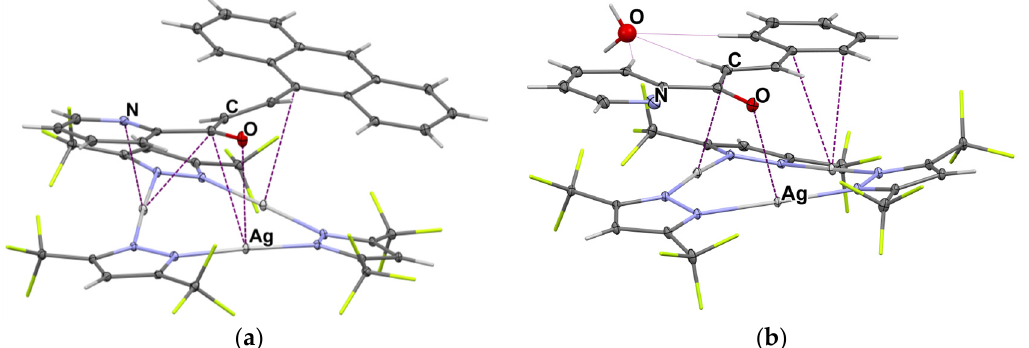
Figure 5. XRD structures of complexes E-1Ag ( a ) and E-2Ag ( b ) with thermal ellipsoids set at the 15% probability level. Hydrogen and fluorine atoms are sticks for clarity.